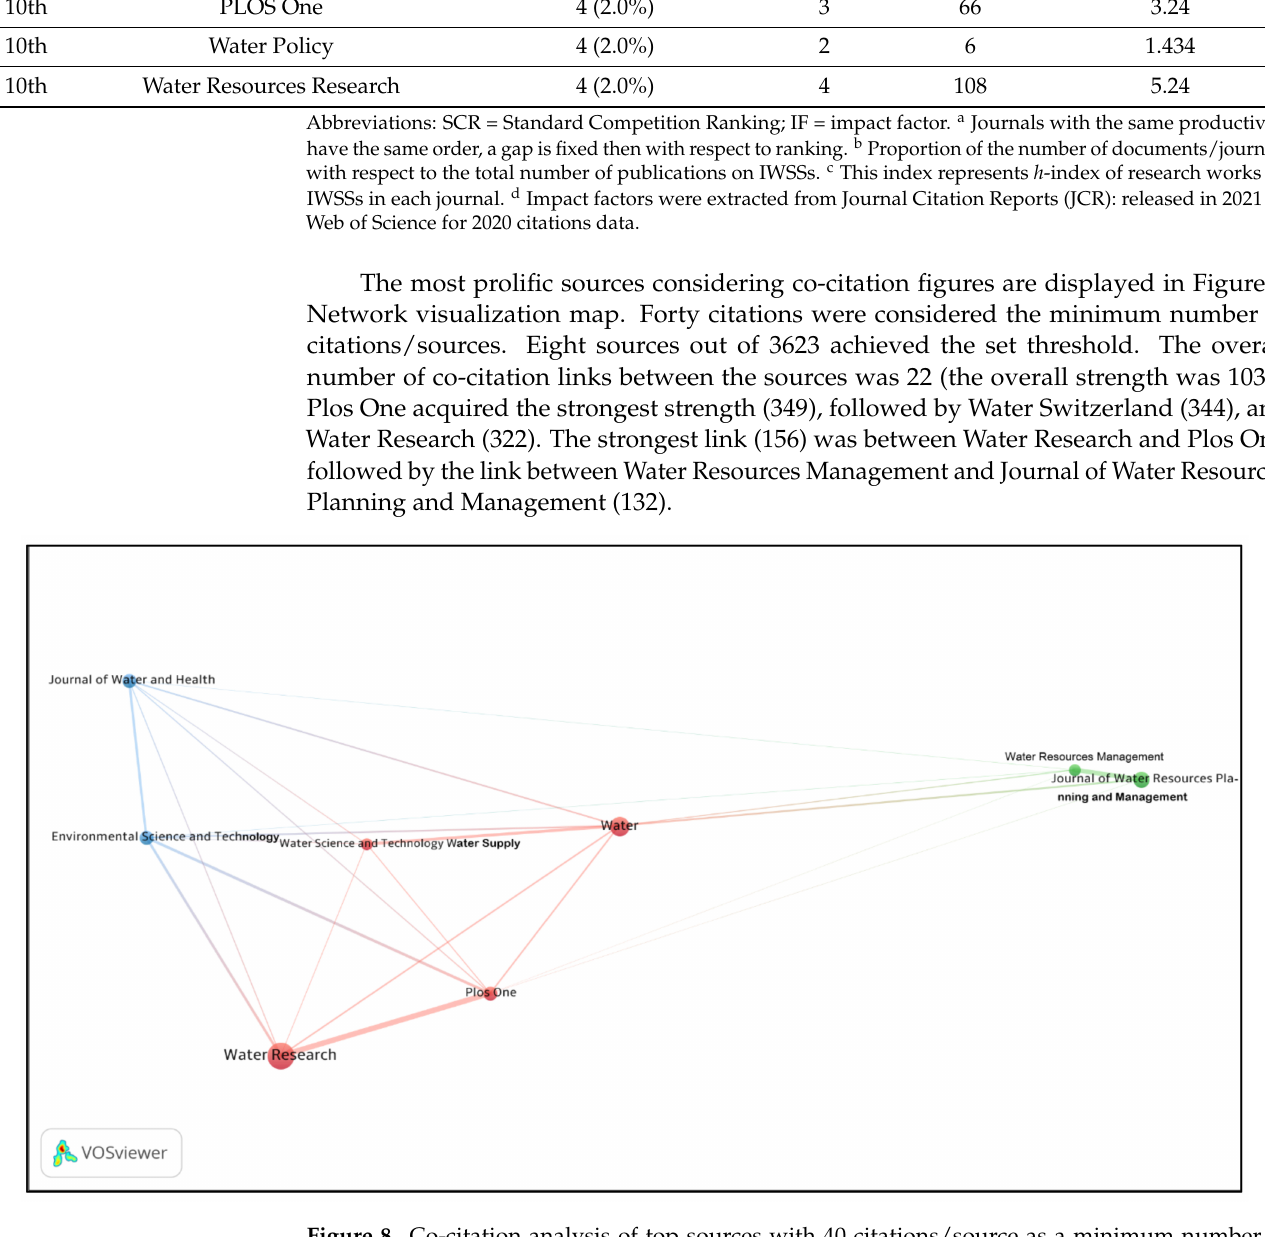
Figure 8. Co-citation analysis of top sources with 40 citations/source as a minimum number of citations (network visualization map). Of the 3623 sources, 8 sources met the set threshold. The overall strength of co-citation links was assessed for each source. The selected sources were the ones with the strongest co-citation